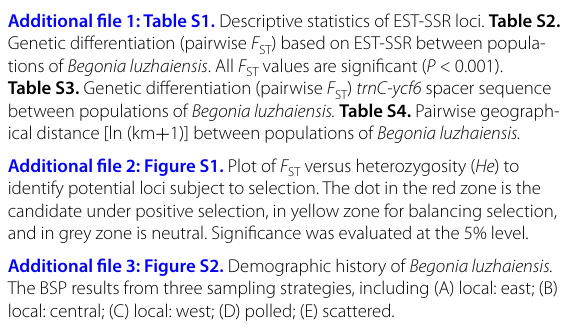
Additional file 1: Table S1. Descriptive statistics of EST‑SSR loci. Table S2. Genetic differentiation (pairwise F ST ) based on EST‑SSR between popula‑ tions of Begonia luzhaiensis . All F ST values are significant ( P < 0.001). Table S3. Genetic differentiation (pairwise F ST ) trnC-ycf6 spacer sequence between populations of Begonia luzhaiensis. Table S4. Pairwise geograph‑ ical distance [ln (km 1)] between populations of Begonia luzhaiensis. + Additional file 2: Figure S1. Plot of F ST versus heterozygosity ( He ) to identify potential loci subject to selection. The dot in the red zone is the candidate under positive selection, in yellow zone for balancing selection, and in grey zone is neutral. Significance was evaluated at the 5% level. Additional file 3: Figure S2. Demographic history of Begonia luzhaiensis. The BSP results from three sampling strategies, including (A) local: east; (B) local: central; (C) local: west; (D) polled; (E) scattered. Abbreviations AIC: akaike information criteria; AMOVA: analysis of molecular variance; BSP: Bayesian Skyline Plot; cpDNA: chloroplast DNA; EST‑SSR: expressed